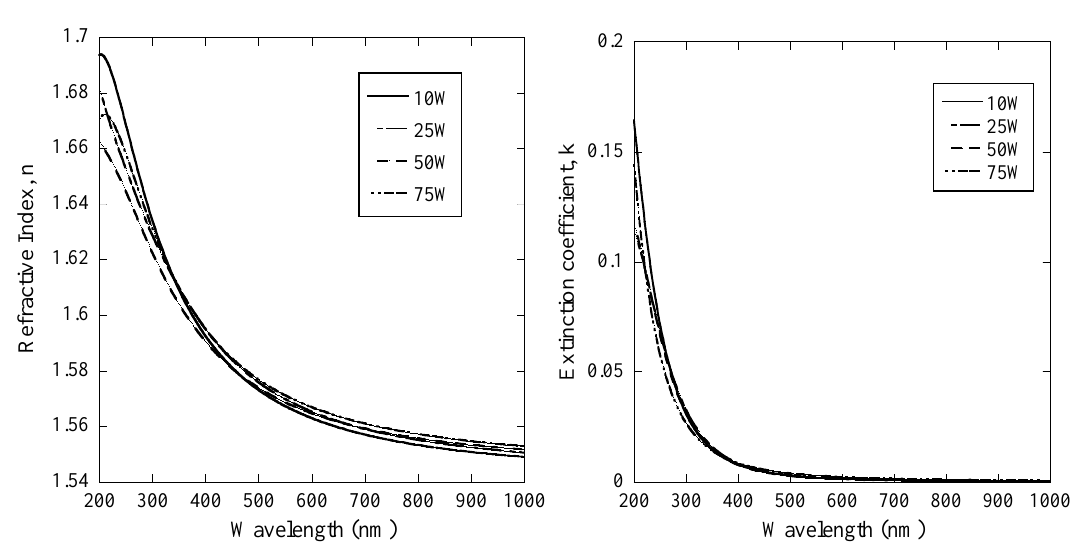
Figure 4. Refractive indices and extinction coefficient of pp–GT thin